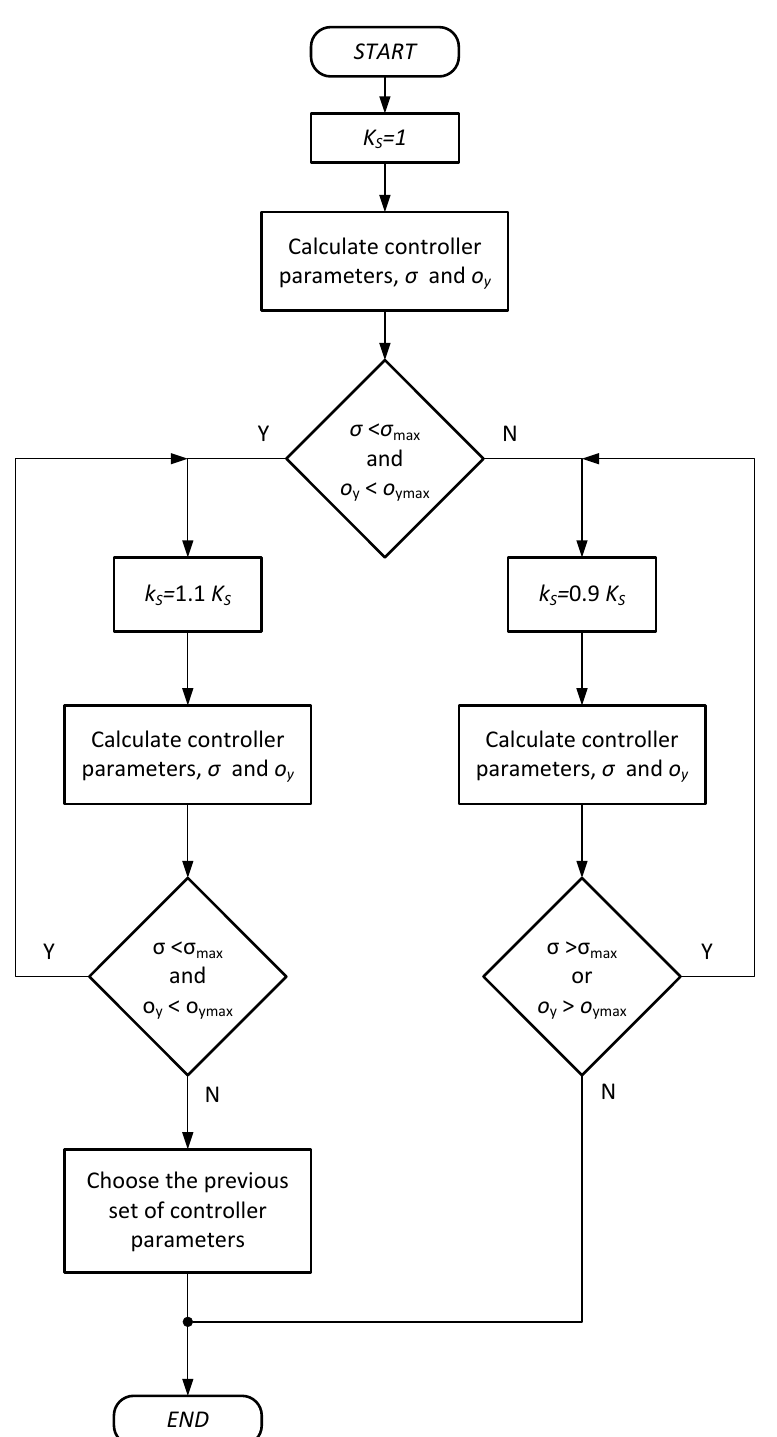
Figure 15. Flowchart of the applied algorithm for automatic calculation of the controller parameters.